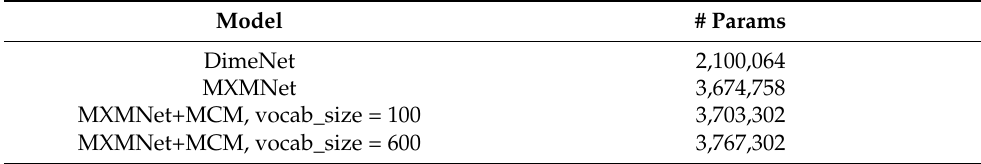
Table A3. Model parameters in DimeNet, MXMNet and